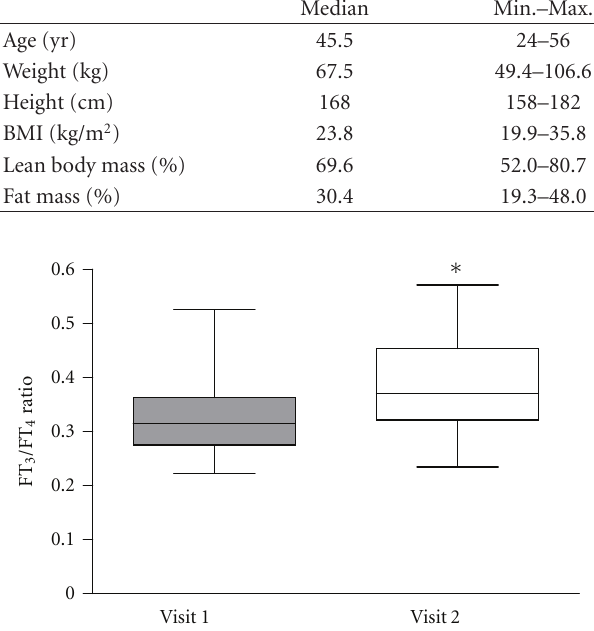
Figure 1: Serum FT 3 /FT 4 ratios of 22 euthyroid Graves patients during BRT (visit 1; grey boxplots) and 12 weeks after cessation of BRT (visit 2, open boxplots). ∗ P = 0 . 007, visit 1 versus visit